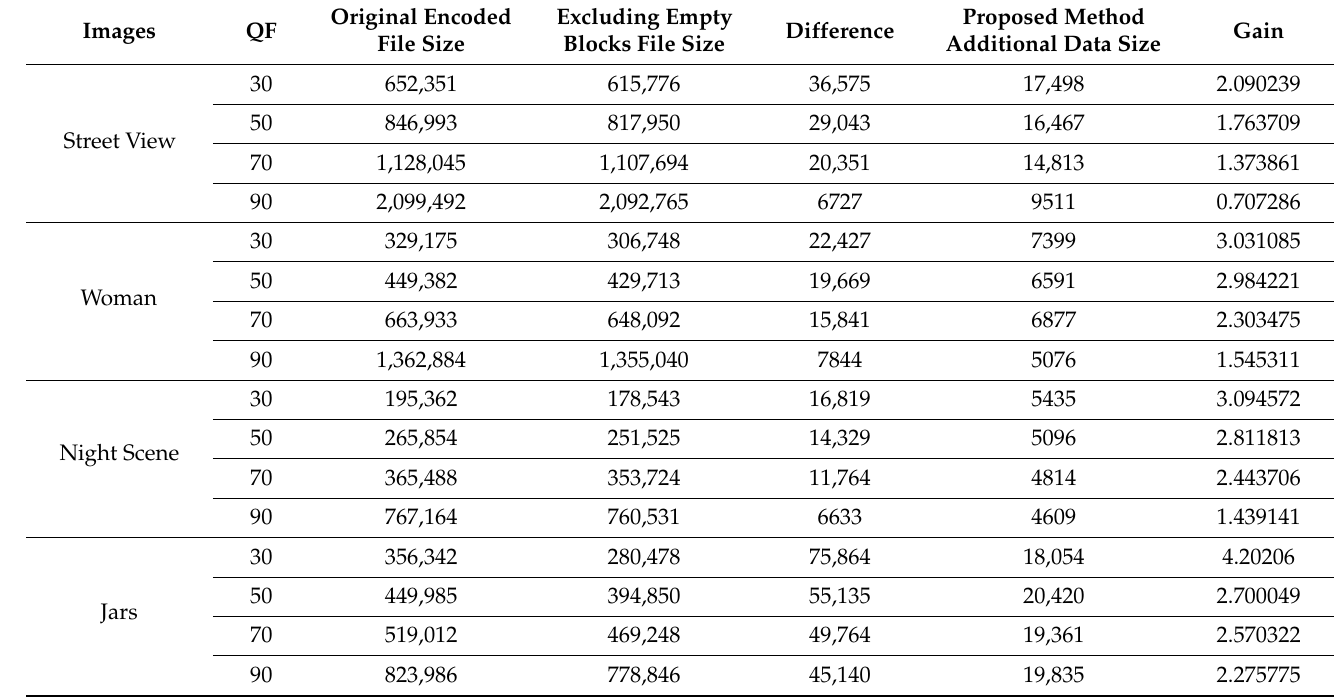
Table 2. Encoded images file size information for Huffman encoding